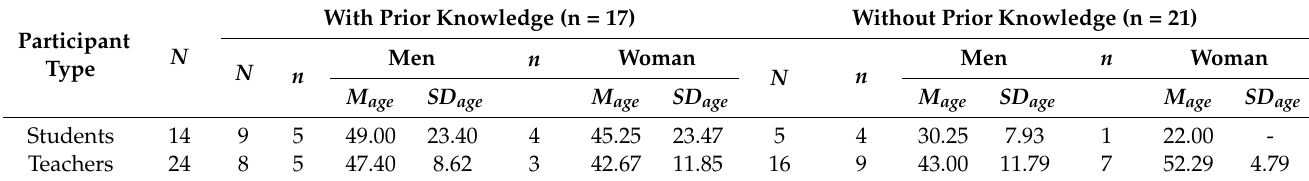
Table 2. Descriptive statistics of the